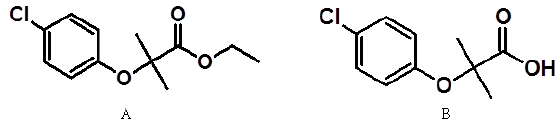
Figure 1. Chemical structure of clofibrate ( A ) and clofibric acid ( B ).